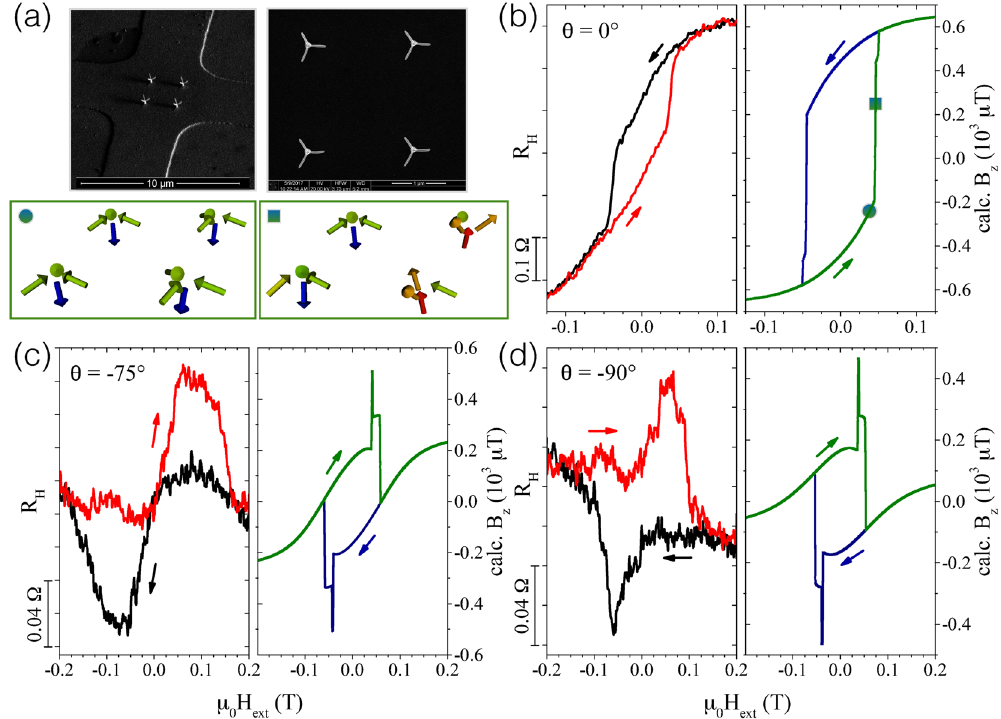
Figure 5. Micro-Hall magnetometry measurement results and macro-spin simulations for nano-trees. ( a ) Top: SEM micrograph of a 2 × 2 array of CoFe nano-trees on a 5 × 5 μ m 2 Hall cross deposited by FEBID (left) and top view of the nano-trees (right). Bottom: Simulations showing the macro-spin configuration at θ = 0° for the up-sweep at two positive fields just before and at the switching of the stems’ magnetization marked by circle and square in ( b ). ( b – d ) Comparison of the magnetic hysteresis loops at T = 30 K and macro-spin calculations for T = 0 K and selected angles 0°, − 75° and − 90°, respectively. Arrows indicate the direction of field